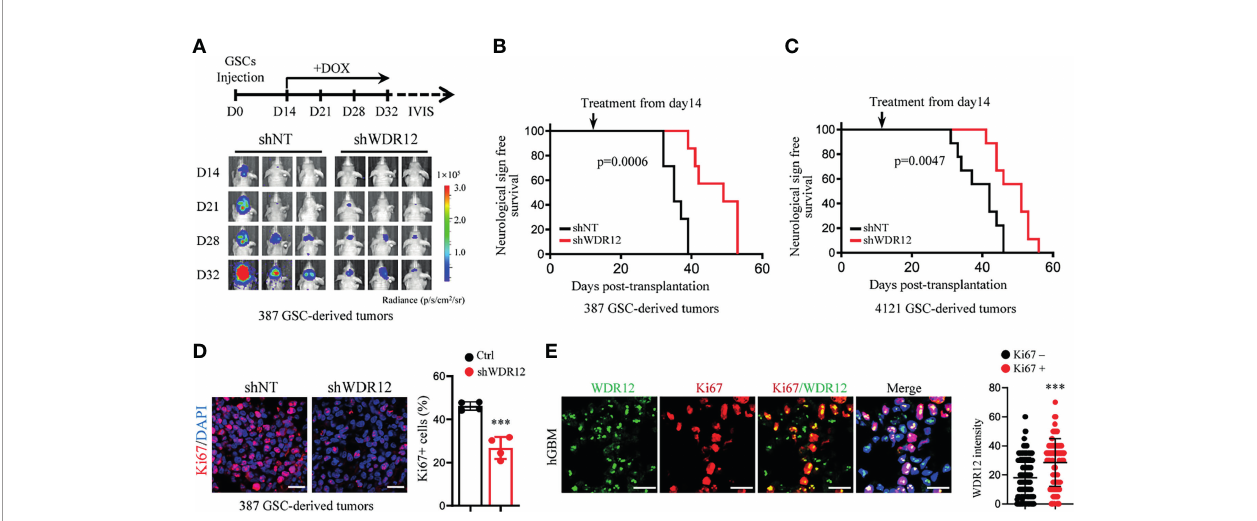
FIGURE 4 | WDR12 promotes GSC-derived tumor growth. (A – D) Luciferase-labeled GSCs were transduced with the inducible-shWDR12 or -shNT and then transplanted into the brains of nude mice (2 × 10 4 cells/mouse). Mice were randomly grouped and treated with Dox (1mg/ml in drinking water) at day 14 after implantation, as showed by schematic representation ( A , top). 387 GSC-derived GBM tumors were tracked by bioluminescence and the representative images are shown (bottom) (A) . Kaplan-Meier survival plots of mice are shown. 387 GSCs groups, n=7 for each group; 4121 GSCs, n=9 for each group (B, C) ; Log rank test. IF staining of Ki67 in GBM tumors derived from 387 GSCs expressing inducible-shNT or inducible-shWDR12 (left). Scale bars, 20 m m. The percentage of Ki67+ cells was quanti fi ed (right, n = 4) (D) . (E) Co-IF staining of WDR12 (green) and Ki67 (red) in human GBM specimens are shown. Nuclei were counterstained with Hoechst (blue) (left). Scale bars, 20 m m. Quanti fi cations of WDR12 staining intensity in Ki67+ (n=106) and Ki67- (n=249) cells (4 random microscope fi elds from 4 tumors) are shown (right). Data are represented as mean ± SD. ***p < 0.001, as assayed by Unpaired Student ’ s